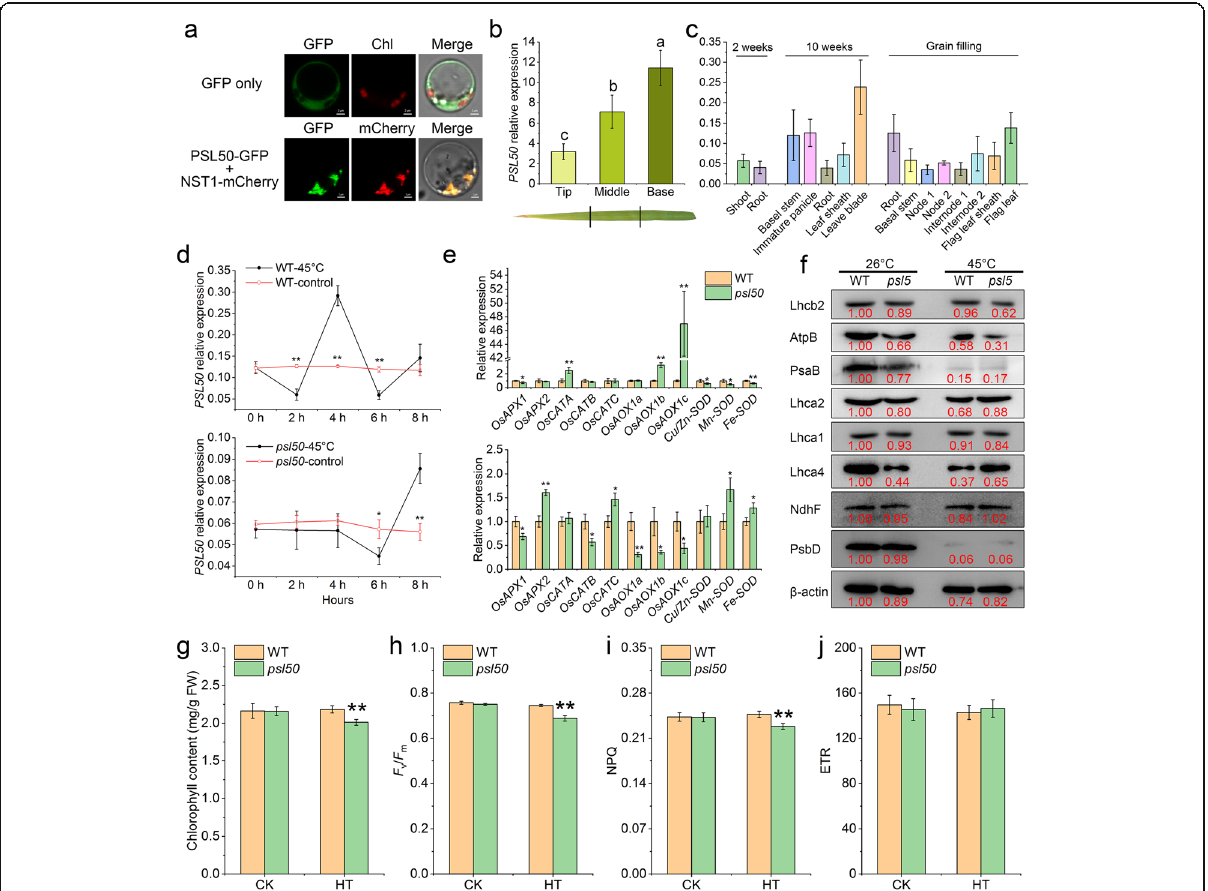
Fig. 3 Subcellular localization and expression analysis of PSL50 . a GFP signals in rice protoplasts. NST1-mCherry was used as a rice protoplast Golgi-tagged marker. b PSL50 expression in different parts of a flag leaf. Different letters indicate significant differences according to one-way ANOVA and Duncan ’ s test ( P < 0.05). Data are mean ± SD ( n = 3). c Relative expression levels of PSL50 in various organs at different growth stages. Data are presented as mean ± SD ( n = 3). d Expression analysis of PSL50 in hydroponic WT and psl50 seedlings under heat stress conditions. Data are mean ± SD ( n = 3). e Expression analysis of ROS scavenging system-related genes in hydroponic WT and psl50 seedlings at 26 °C (upper) and 45 °C (lower) for 12 h. Data are mean ± SD ( n = 3). Rice UBIQUITIN ( LOC_Os03g13170 ) was used as an internal control. f Levels of thylakoid membrane proteins detected in total proteins from top second leaves of 12 d WT and psl50 hydroponic seedlings at 26 °C and 45 °C for 50 h. Image J was used for the quantification of immunoblot results and these experiments were repeated at least twice with similar results. g Leaf chlorophyll content of hydroponic WT and psl50 seedlings before and after heat treatment. Data are means ± SD ( n = 3). h-j Changes of photochemical efficiency of PSII ( F v / F m ), non-photochemical fluorescence quenching (NPQ) and relative PSII electron transport rate (ETR) in WT and psl50 under heat treatment. The data for heat treatment in g-h were collected after a 7-d recovery at 26 °C. Seedlings were hydroponically grown at 26 °C for 12 d and then treated at 45 °C for 50 h following a 7-d recovery at 26 °C. CK, normal growth condition at 26 °C; HT, heat treatment at 45 °C followed by recovery at 26 °C for 7 d. Data are means ± SD ( n = 5). Asterisks indicate significant difference by Student ’ s t test (** P < 0.01 and * P <